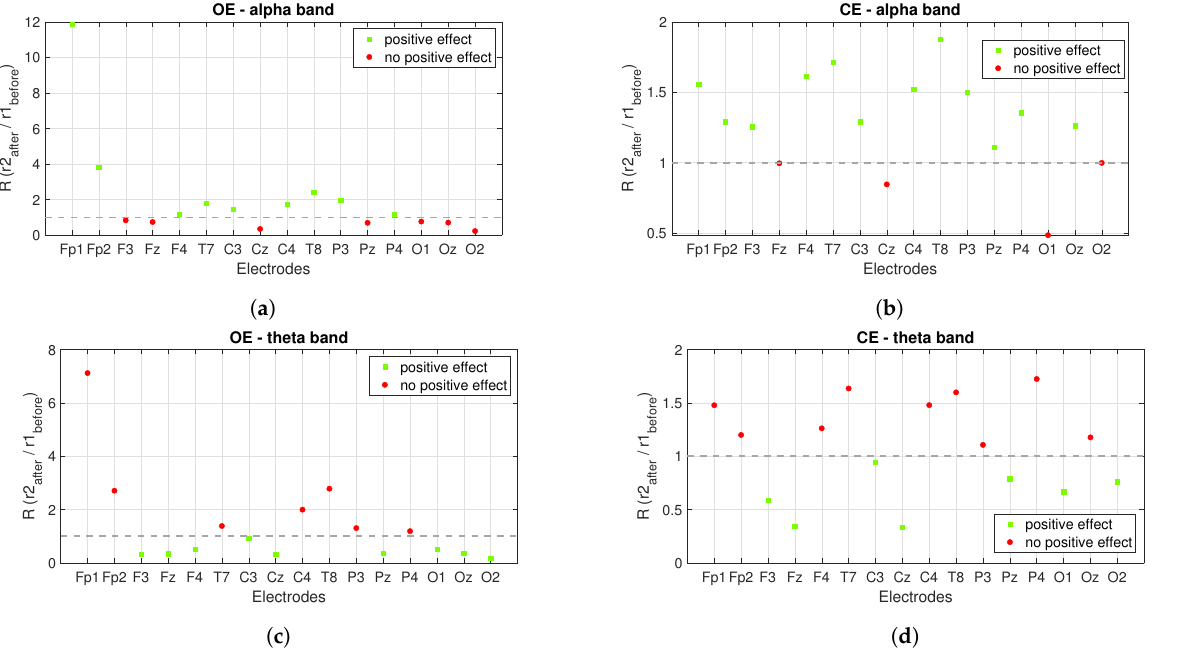
Figure 8. The long-term effect of PBM stimulation on the power spectrum when alpha and theta bands are observed. The figures show the power ratios between the r 2 after stimulation and the r 1 before stimulation. ( a ) shows the power ratios for the alpha band at OE , while Figure ( b ) shows the power ratios at CE . ( c ) presents the power ratios for the theta band at OE , while ( d ) is for CE .